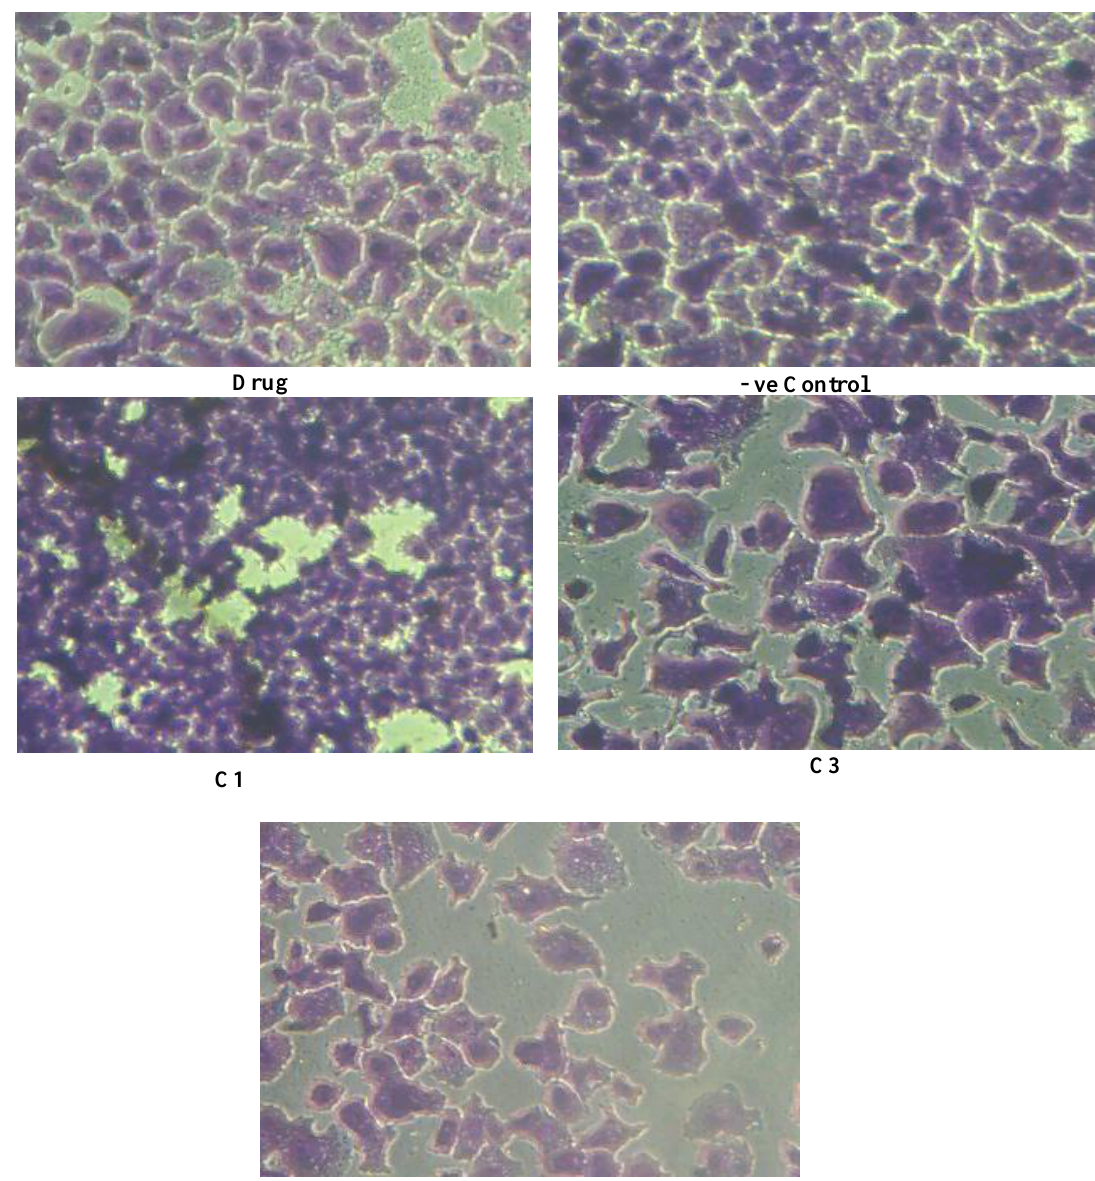
Fig 3 : The morphologicl effects exerted by C1,C3, and C3A on HEP-2 , photographs were taken using a Nikon inverted light microscope (20x